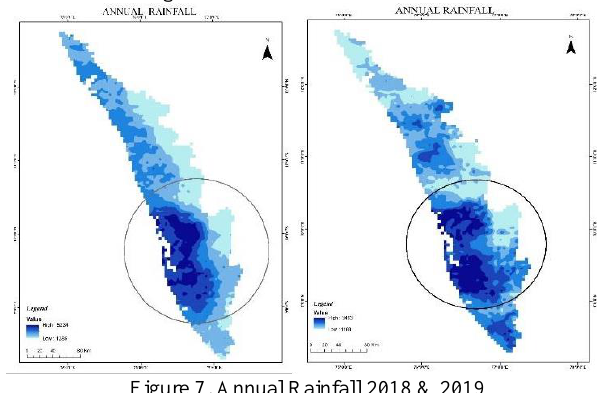
Figure 7. Annual Rainfall 2018 & 2019